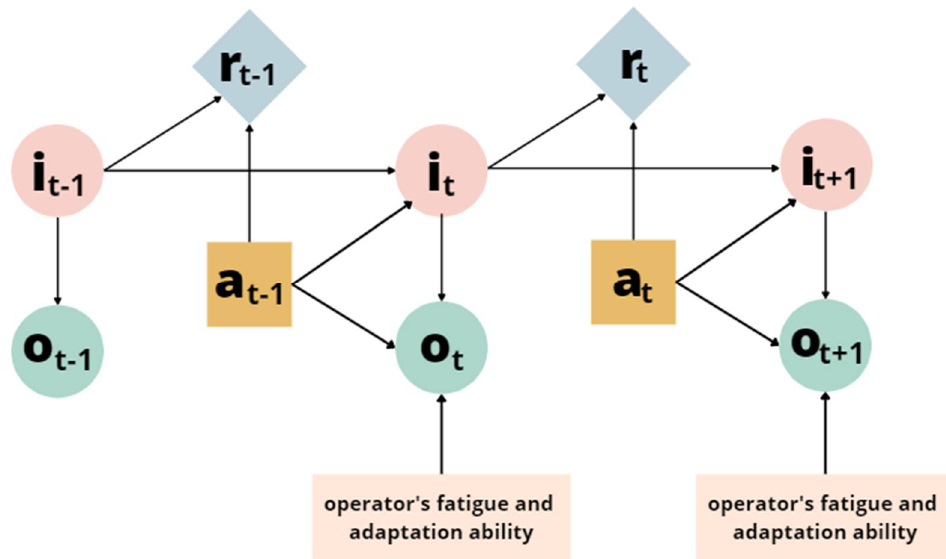
Figure 9. A Framework of POMDP with Behavior